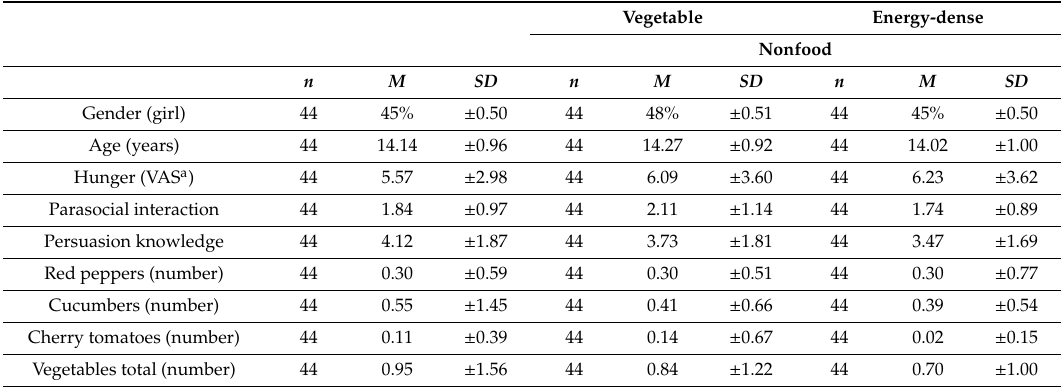
Table 1. Variables measured by the condition a. ; ( N =